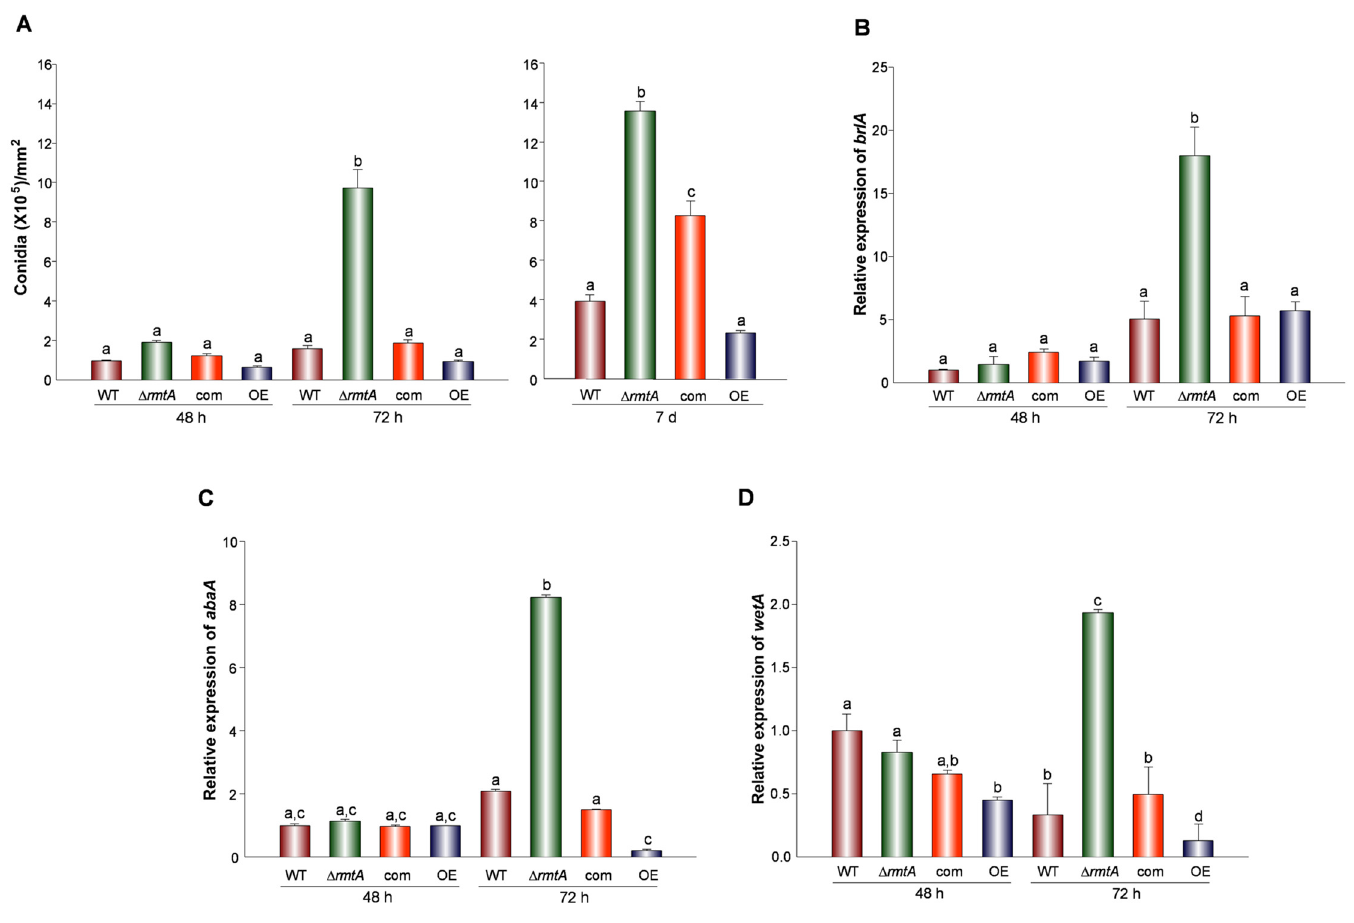
Fig 4. Effect of rmtA on conidiation. (A) Quantification of conidia. Aspergillus flavus wild type (WT), Δ rmtA , complementation (com) and OE rmtA (OE) strains were grown on PDA medium for up to 7 days at 30°C. Seven millimeter cores were taken from each culture. Conidia were counted using a hemocytometer. Values represent the average of 3 replicates. Error bars represent standard error. (B, C, D) qRT-PCR expression analysis of brlA . abaA and wetA , respectively. Strains were inoculated in PDB stationary cultures (10 6 spores/ml), and were grown for 72 h at 30°C. The error bars represent standard errors. Values were normalized to the expression levels in the wild type, considered as 1. Different letters on the columns indicate values that are statistically different (p < 0.05).